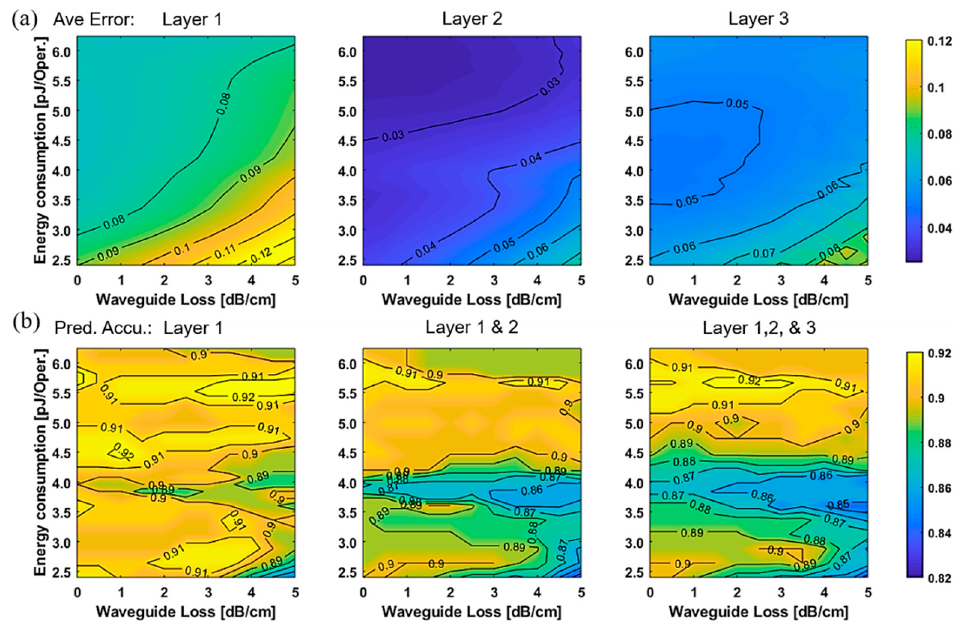
Figure 8. Investigation performance of the PDNN on computing energy and waveguide loss. ( a ) Calculated average NRMSE from output data obtained from Layers 1–3; ( b ) Corresponding prediction accuracy when Layer 1, Layers 1,2, and Layers 1–3 are implemented with photonic neuron layers.